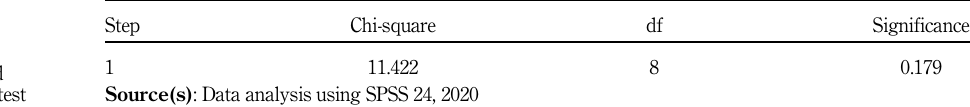
Table 4. Hosmer and Lemeshow test